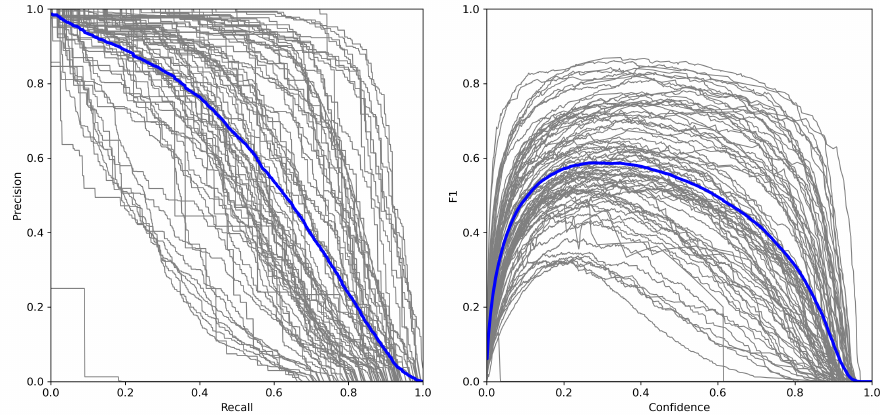
Figure 6. Curves of precision-recall and F1-score during the evaluation process. The searched model was trained for 300 epochs. Blue line denotes the averaged value among all 80